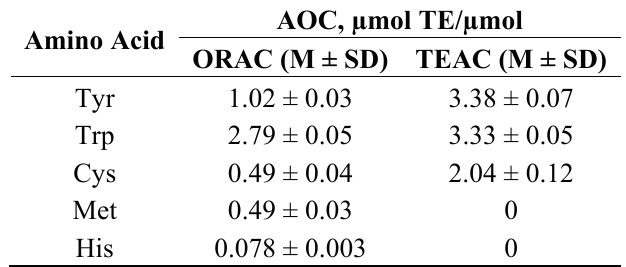
Table 1. AOC of free amino acids against peroxyl radical (ORAC) and ABTS cation radical ( ТЕАС ).